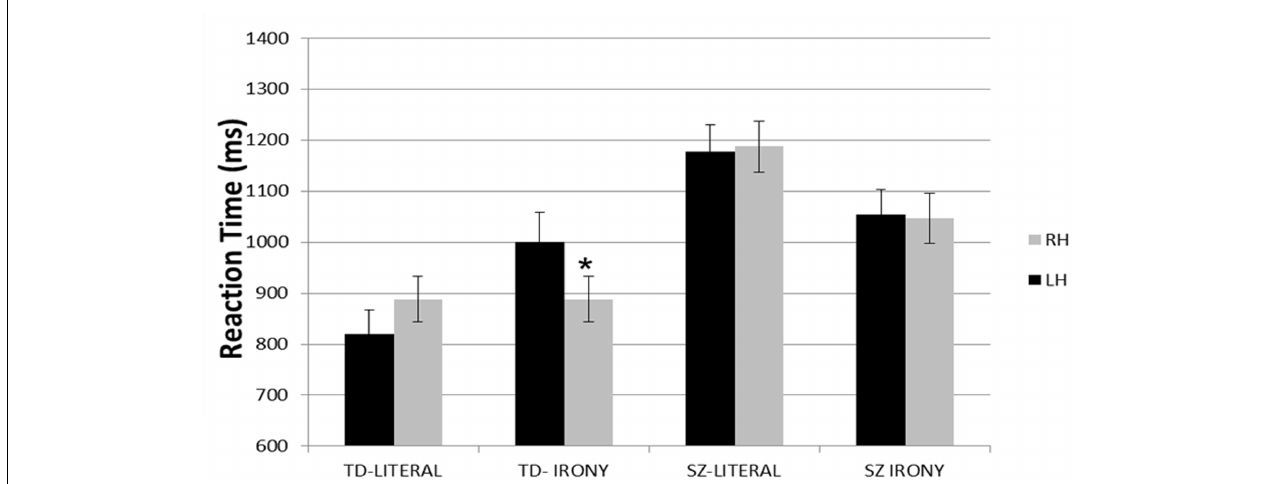
FIGURE 2 | Reaction times (and SE) within each hemisphere, by group and stimulus type. ∗ p < 0.05.